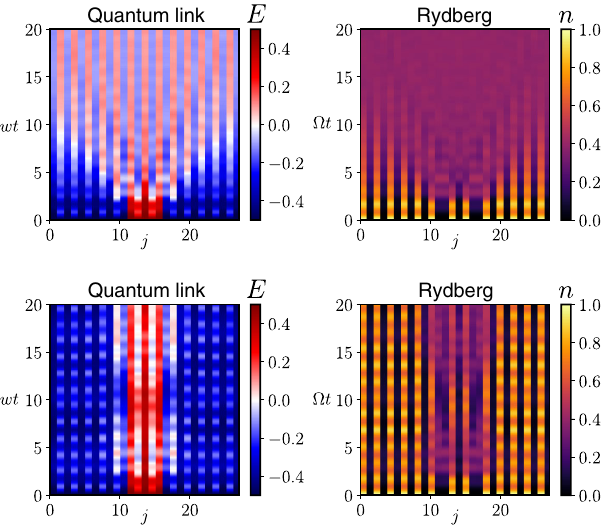
FIG. 9. θ angle and string-breaking dynamics. The evolution of a bare particle-antiparticle pair state is displayed in terms of space- and time-dependent electric field in the QLM (left-hand panels) and of the density of excited atoms in the Rydberg array (right-hand panels), with m ¼ − δ ¼ 1 . 5 Ω and L ¼ 28 . Simu- lations in the top row have Δ ¼ 0 , corresponding to the deconfined field theory with θ ¼ π . Effects of confinement emerge in the second row, where a nonvanishing Δ ¼ 0 . 3 Ω stabilizes the electric